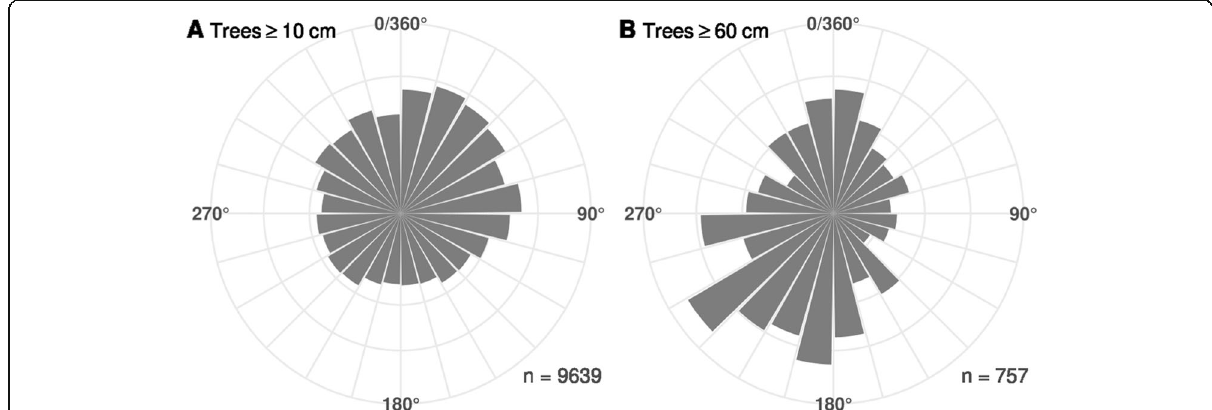
Fig. 4 Directional diagrams showing the position of all basal pieces (i.e., the largest-diameter segment of a fallen tree) of deadwood ≥ 10 cm diameter ( a ), and large-diameter ( ≥ 60 cm DBH) deadwood ( b ). Each concentric gridline of the rose diagram represents 2% of the total